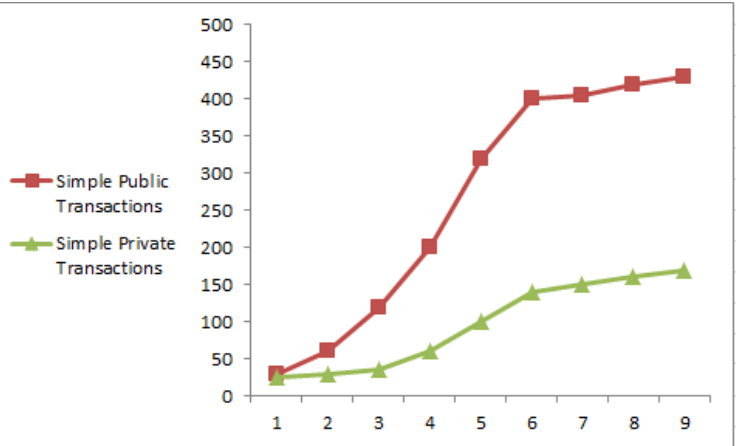
Figure 22. Maximum throughput vs. block time.